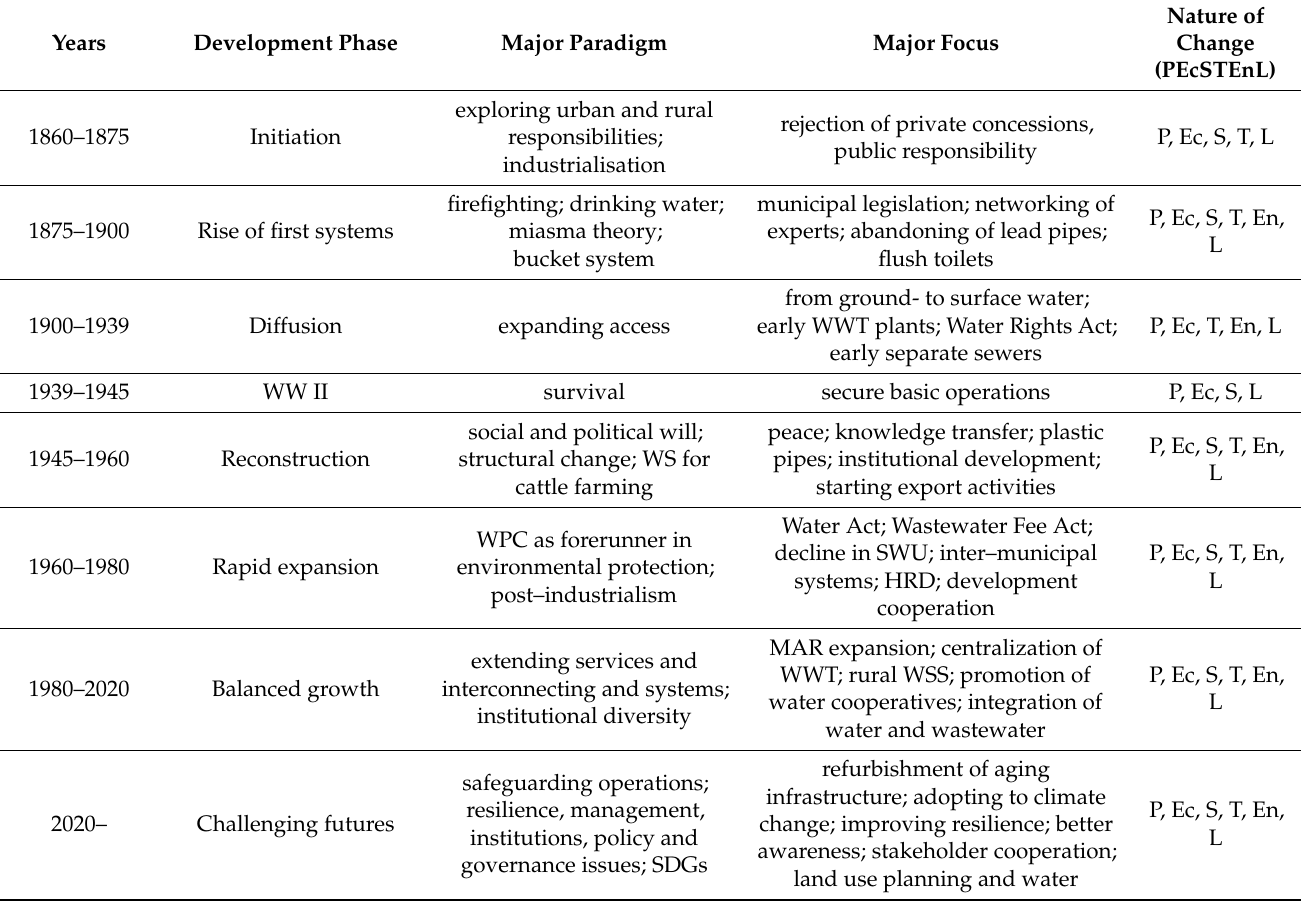
Table 1. Major development phases, paradigms, and foci in Finnish water services evolution, 1860– 2020 and